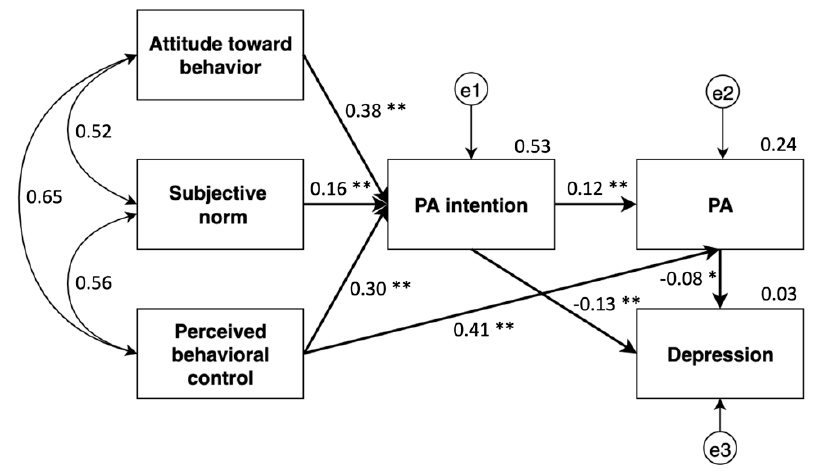
Figure 2. Final structural equation model among study variables; ** p < 0.01; * p < 0.05.